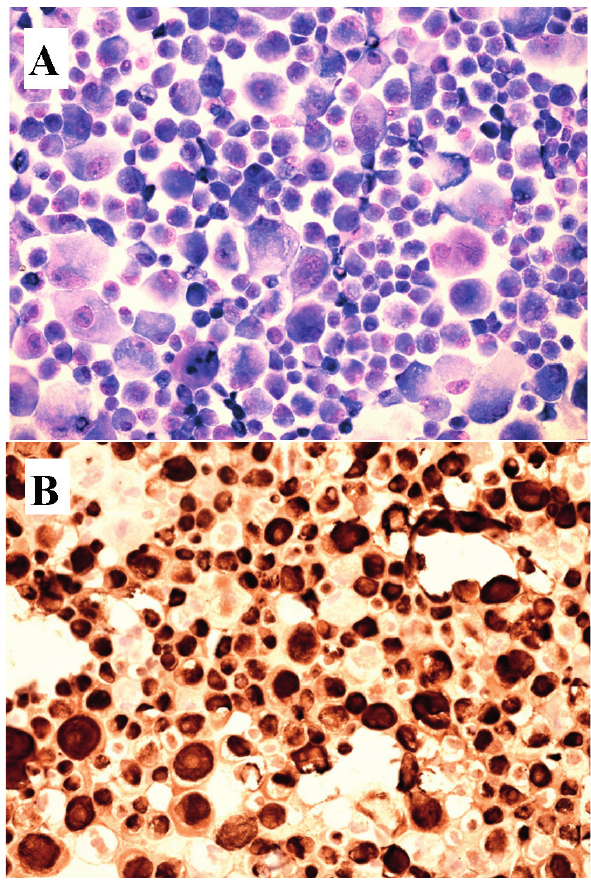
Fig. 2. Primary cell line derived from lymph node metastasis. Cytological features of malignity in this case include anisocy- tosis, anisokaryosis, increased nuclear-cytoplasmic (N/C) ratio and conspicuous nucleoli (May-Grünwald-Giemsa, 200x, cyto- spin) (A). Primary cell line derived from lymph node metastasis after second passage. Immunohistochemical stain for cytokera- tin shows positivity in most of cultured cells (Cytokeratin AE1/ AE3, 200x, cytospin) (B).